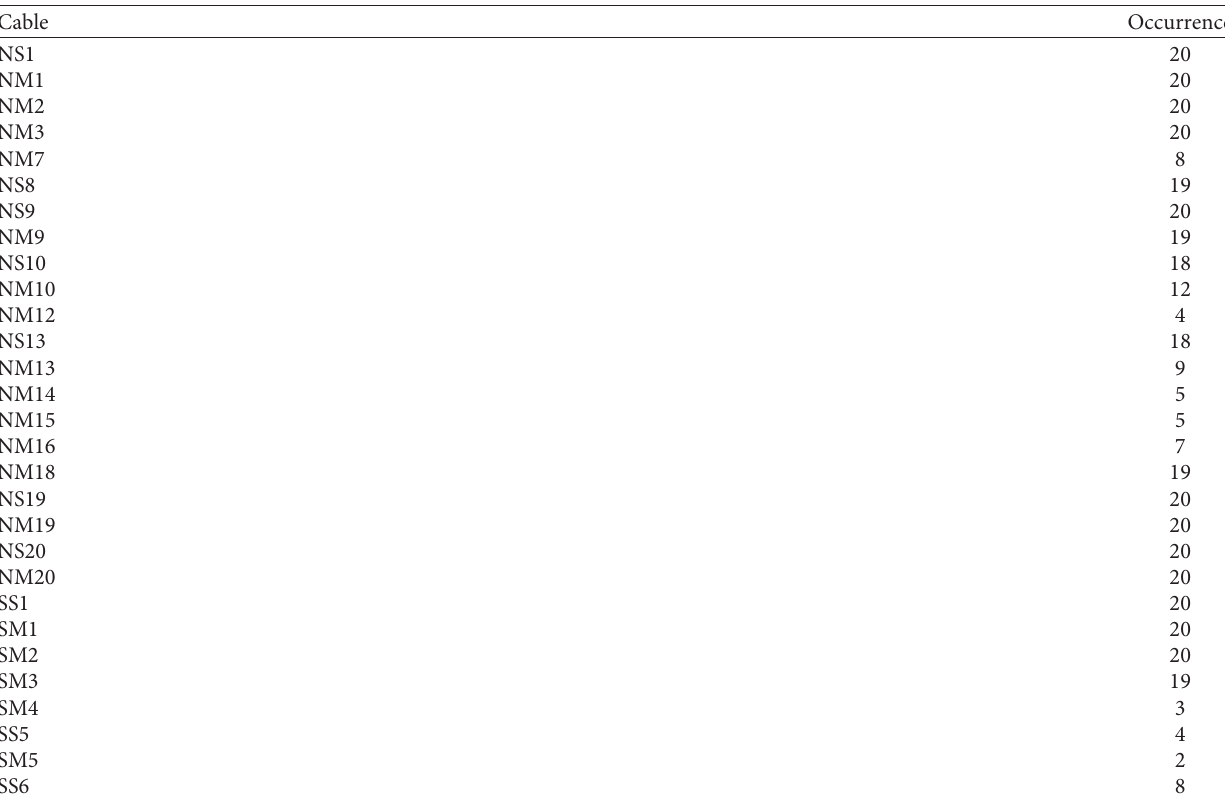
Table 3: Number of occurrences for each